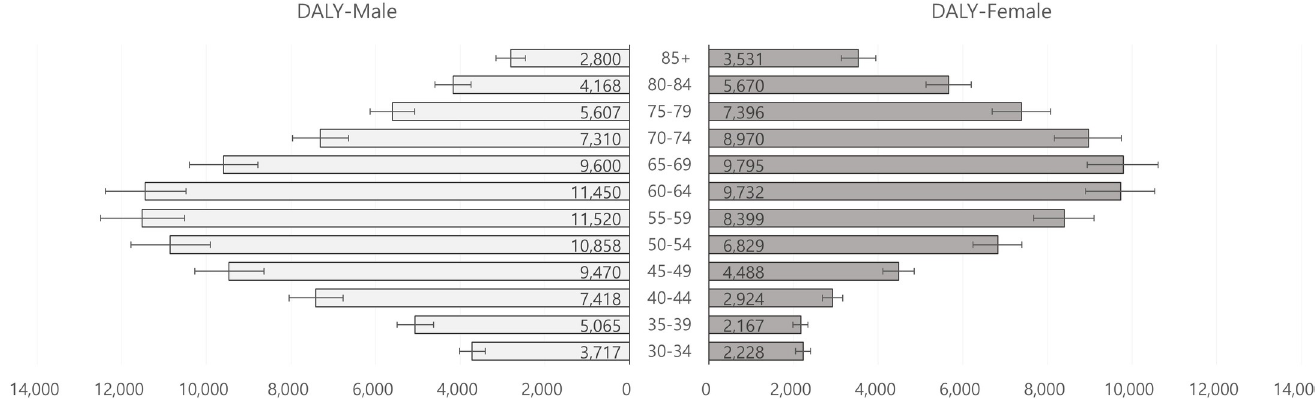
Fig 2. Estimated DALYs per 100,000 population by gender and age group. DALYs, disability-adjusted life years. Unit: DALYs per 100,000